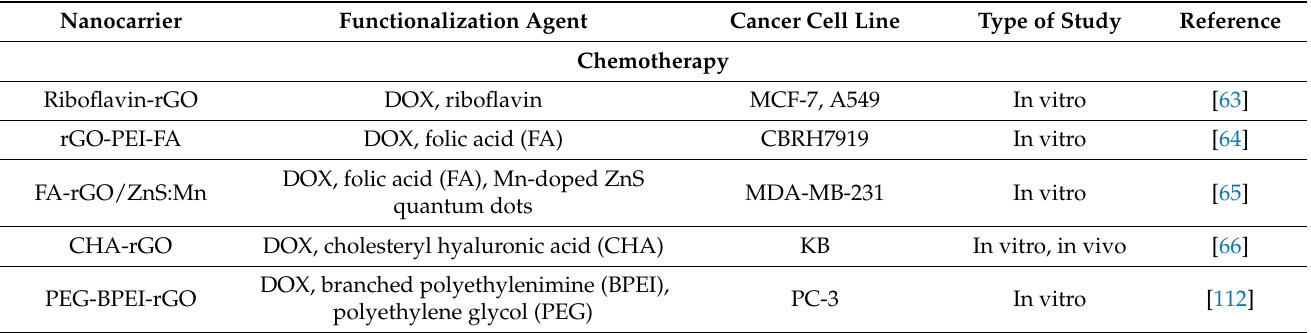
Table 2. Summary of functionalized rGO-based nanocomposites used for cancer therapy. Nanocarrier Functionalization